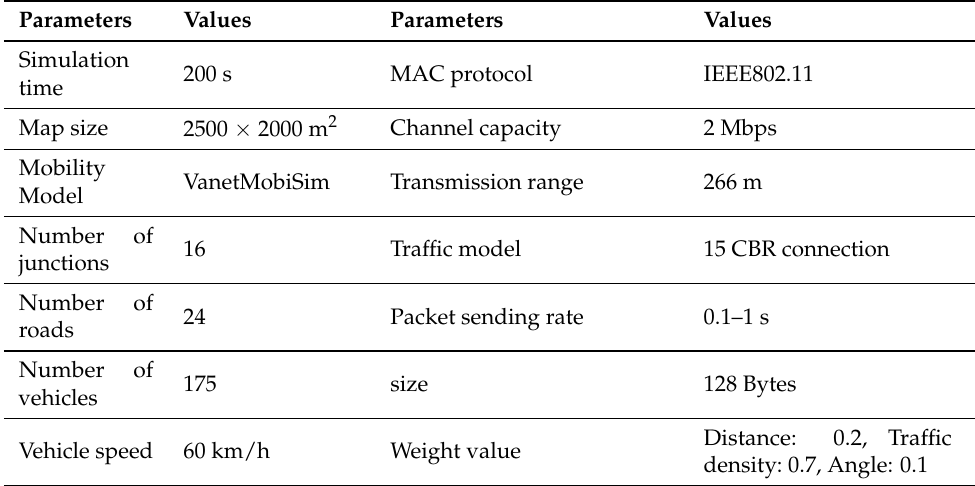
Table 1. Simulation